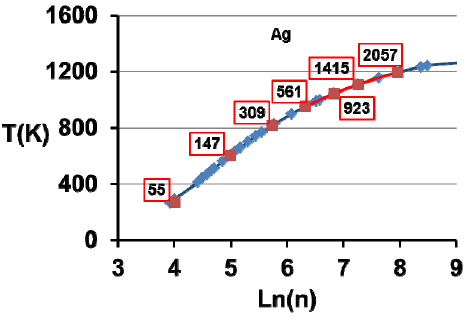
Figure 8. The formation temperatures of superclusters containing n atoms. The formation temperatures of Ag critical superclusters are plotted versus the critical number n that they contain. The superclusters with magic atom numbers are represented by